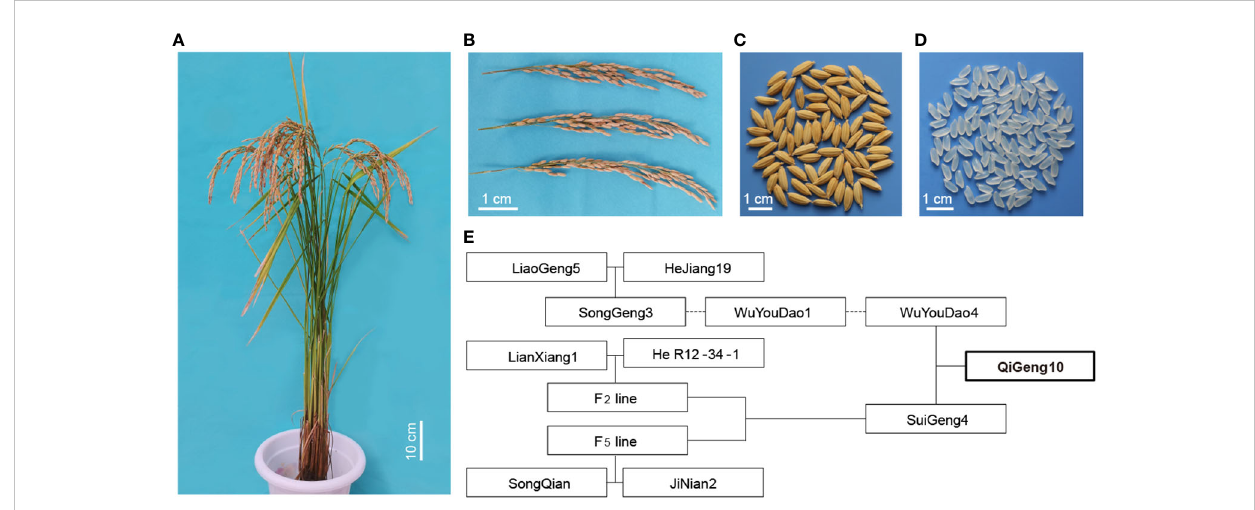
FIGURE 1 The of plant type, panicle phenotype, seeds phenotype, grains phenotype and pedigree of QG10. (A) The plant type of QG10; (B) The panicle morphology of QG 10; (C) The seed morphology of QG10; (D) The grain morphology of QG10; (E) The pedigree of